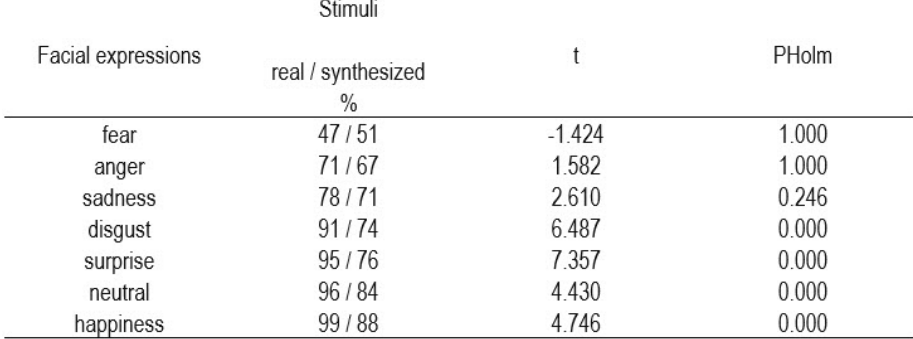
Comparison of recognition accuracy of different expressions for real and synthesized facial stimuli